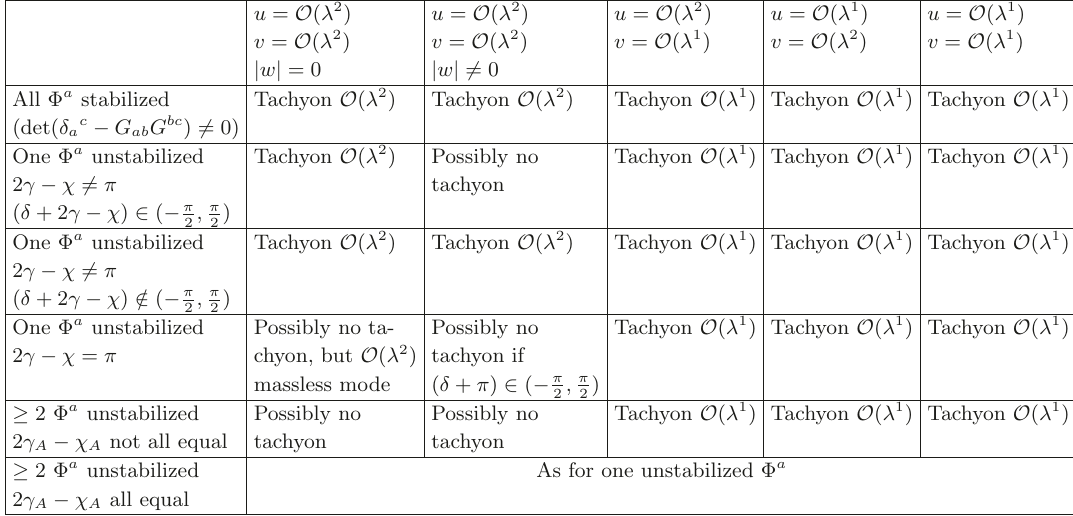
Stability constraints for uncorrected K¨ahler potential and W (1) amn = 0, with u